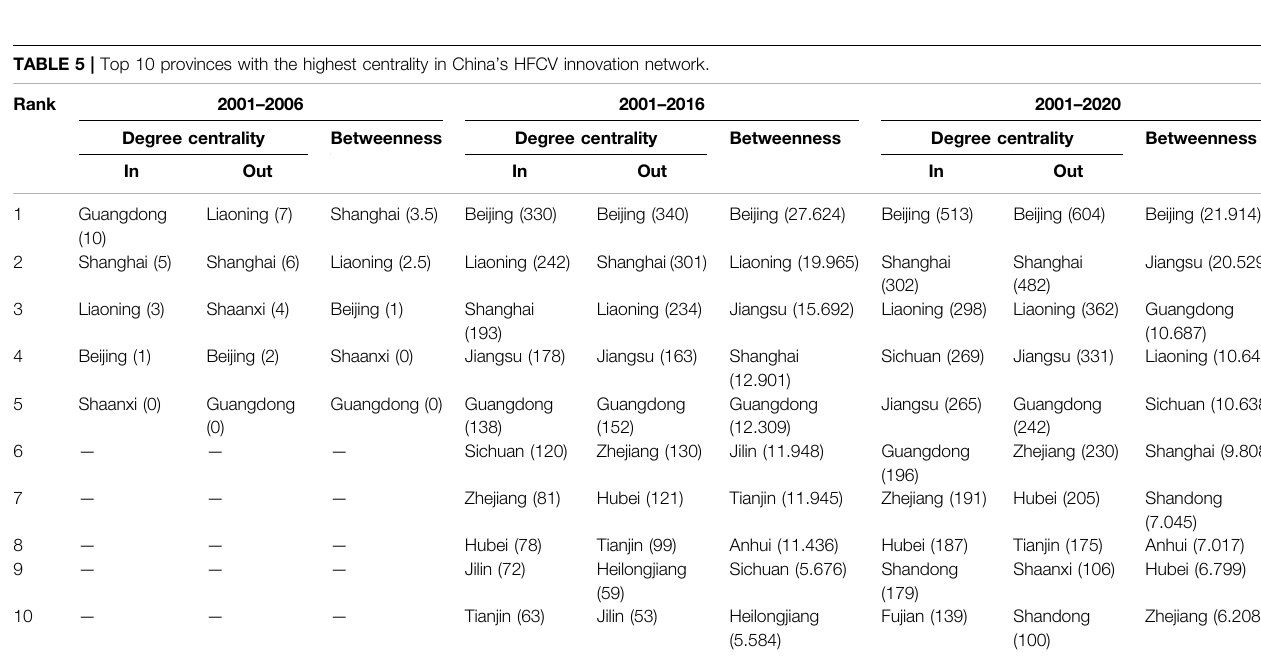
FIGURE 4 | Province ’ s number of invention patents in China ’ s HFCV industry.